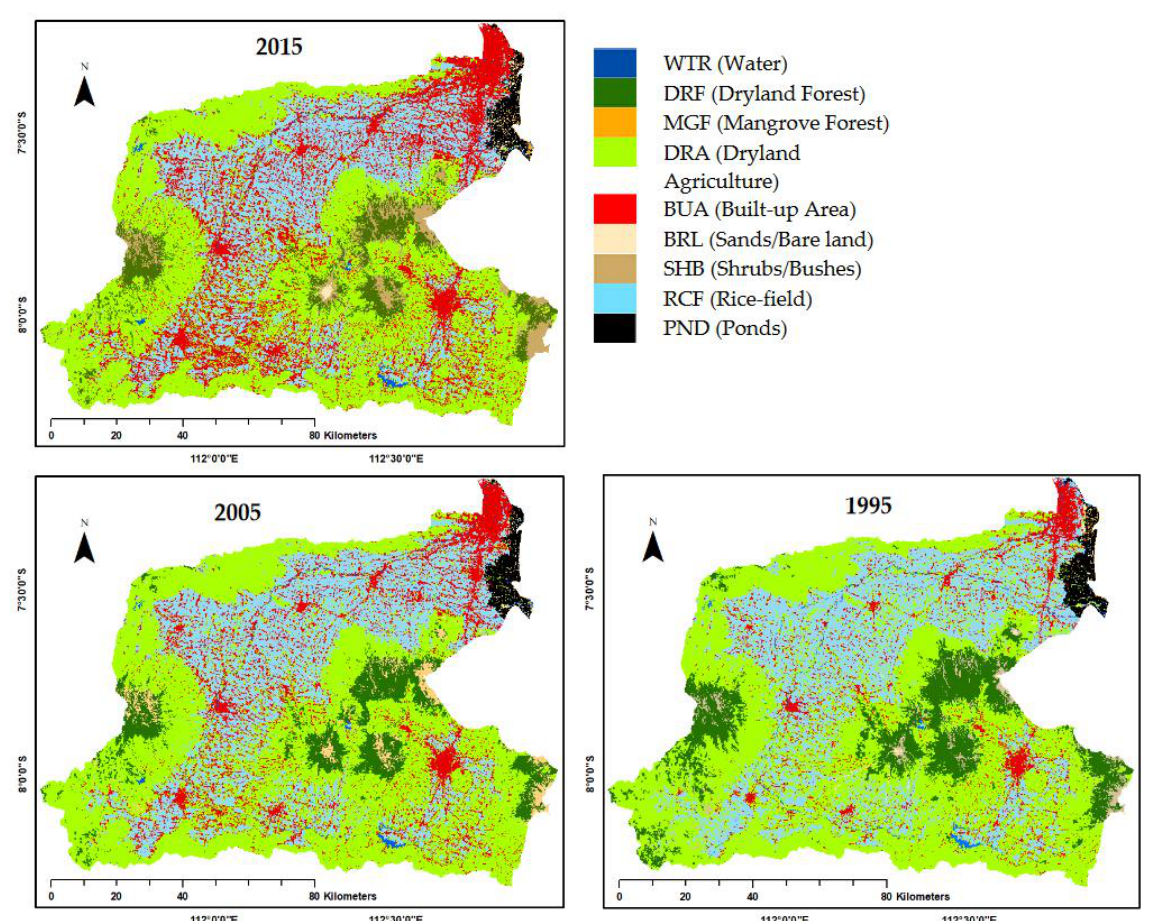
ISPRS Int. J. Geo-Inf. 2023 , 12 , x FOR PEER REVIEW Figure 3. Land-use maps of Brantas River Basin in 1995, 2005, and 2015. Figure 3. Land-use maps of Brantas River Basin in 1995, 2005, and 2015.